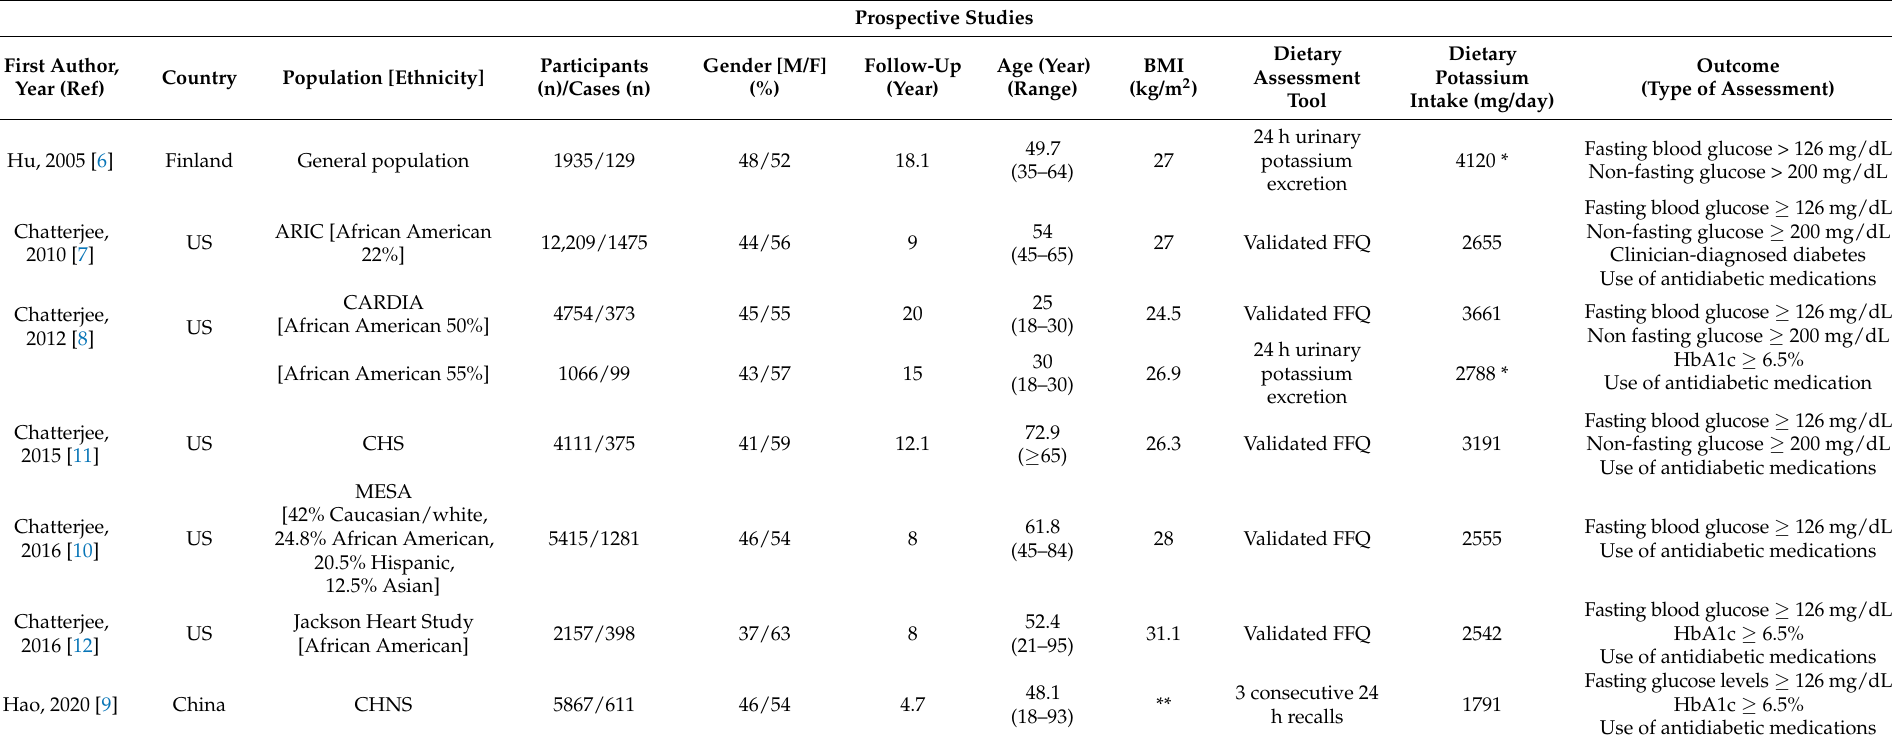
Table 1. Characteristics of the studies included in the systematic